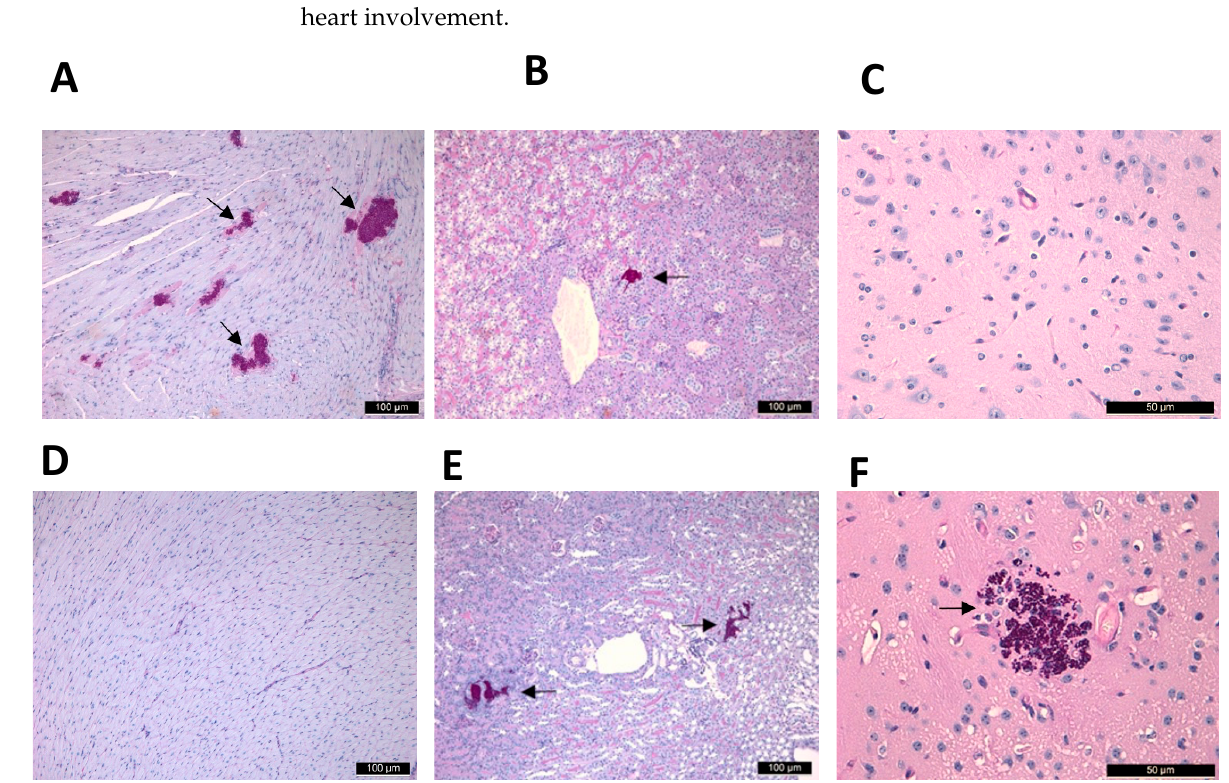
Figure 6. Histopathological findings of the heart, kidney and cerebrum with Periodic Acid Schiff staining from fungal burden experiments. Neutropenic mice infected with isolate I-156 (South American clade) sacrificed and dissected on day 2 showed small fungal foci in the hearts ( A ) and kidneys ( B ), but the cerebrum ( C ) did not contain fungal cells. The histopathology regardless that mice were AMB-treated or not was the same for all isolates and clades on day 2. In case of a mouse infected with isolate 12,372 (East Asian clade) and treated with 1 mg/kg of AMB, on day 6 the heart showed normal histology without fungal involvement ( D ), but the kidney ( E ) and cerebrum ( F ) showed fungal cells. Fungal lesions were indicated with black arrows. Magnification, ×100 .